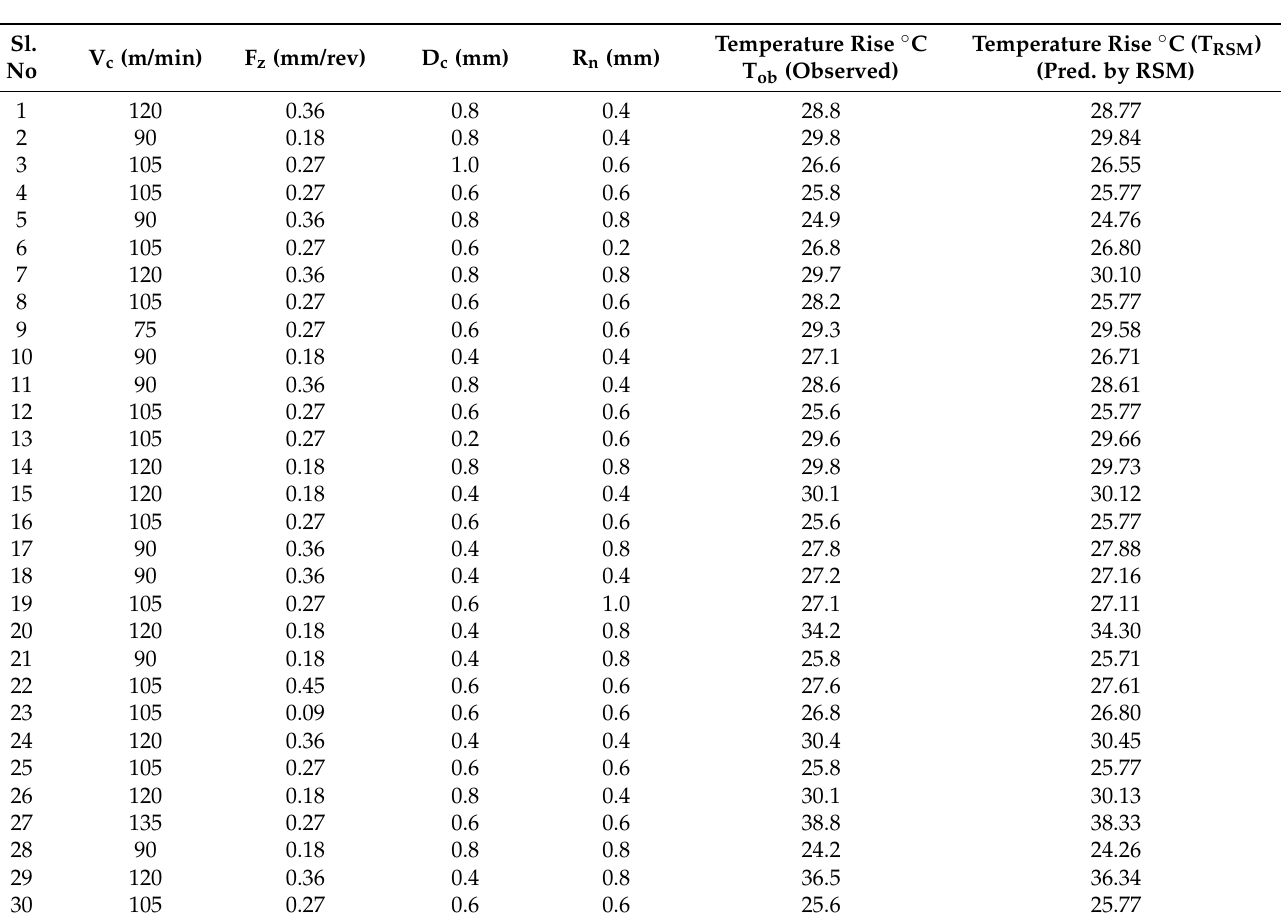
Table 2. Responses to experimental